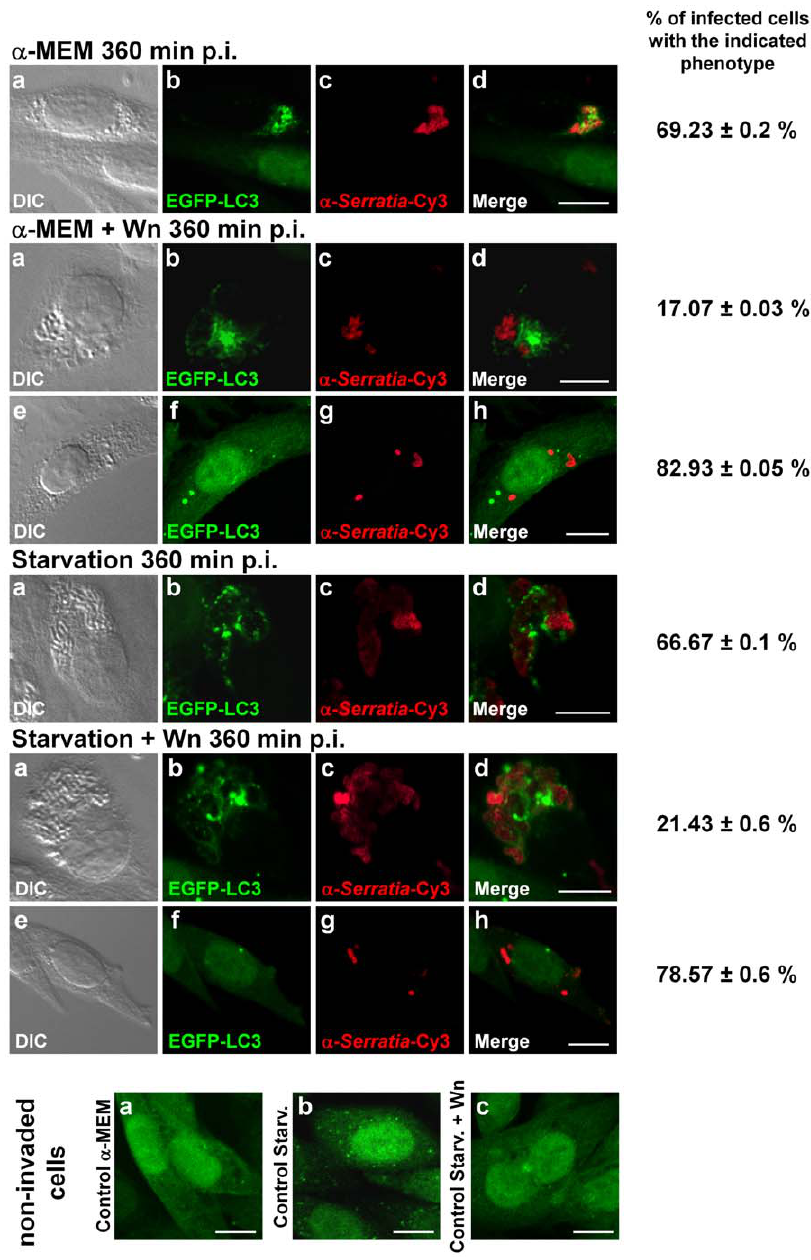
Figure 8. Confocal microscopy analysis of the induction or inhibition of autophagy on Serratia invasion in CHO cells. CHO-EGFP-LC3 cells subjected to the invasion assays as described in Fig. 5B were visualized by confocal laser microscopy. Bacteria were detected with antibodies anti- Serratia coupled with a secondary antibody labeled with Cy3. Representative DIC (a and e), EGFP-LC3 green fluorescence (b and f), red fluorescence labeled bacteria (c and g) and merged fluorescence images (d and h) are shown. In the assays where wortmannin was used, representative images from both the scarce SeCV observed (a-d) and from barely invaded cell fields (e-h) are shown. The lower panel shows representative images of control, non-invaded cells incubated with a -MEM, in starvation medium or in starvation medium + Wn (green EGFP-LC3 fluorescence, a, b and c, respectively). Bars: 10 m m. The percentage of invaded cells displaying the phenotype shown in the images in the corresponding row is indicated to the right. At least 200 cells were counted for each condition; the media 6 S.D. is shown for two independent experiments.